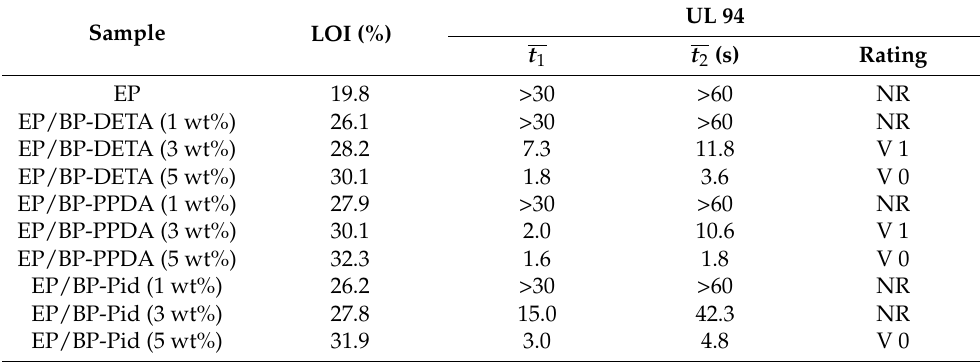
Table 2. LOI and UL-94 vertical burning test data of pure EP and its nanocomposites.